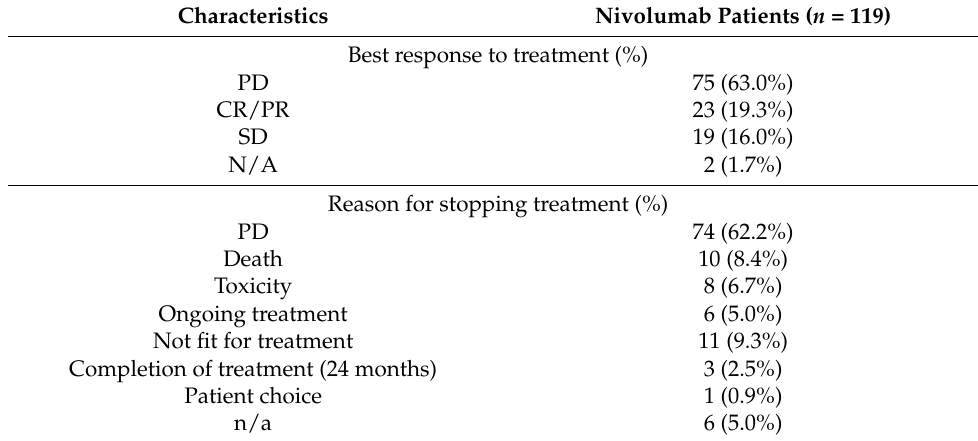
Figure 1. ( a ) Line of palliative systemic treatment. Best response to treatment for ( b ) all patients; ( c ) based on previous treatment; ( d ) based on PD-L1 status. Table 3. Treatment response and reasons for stopping